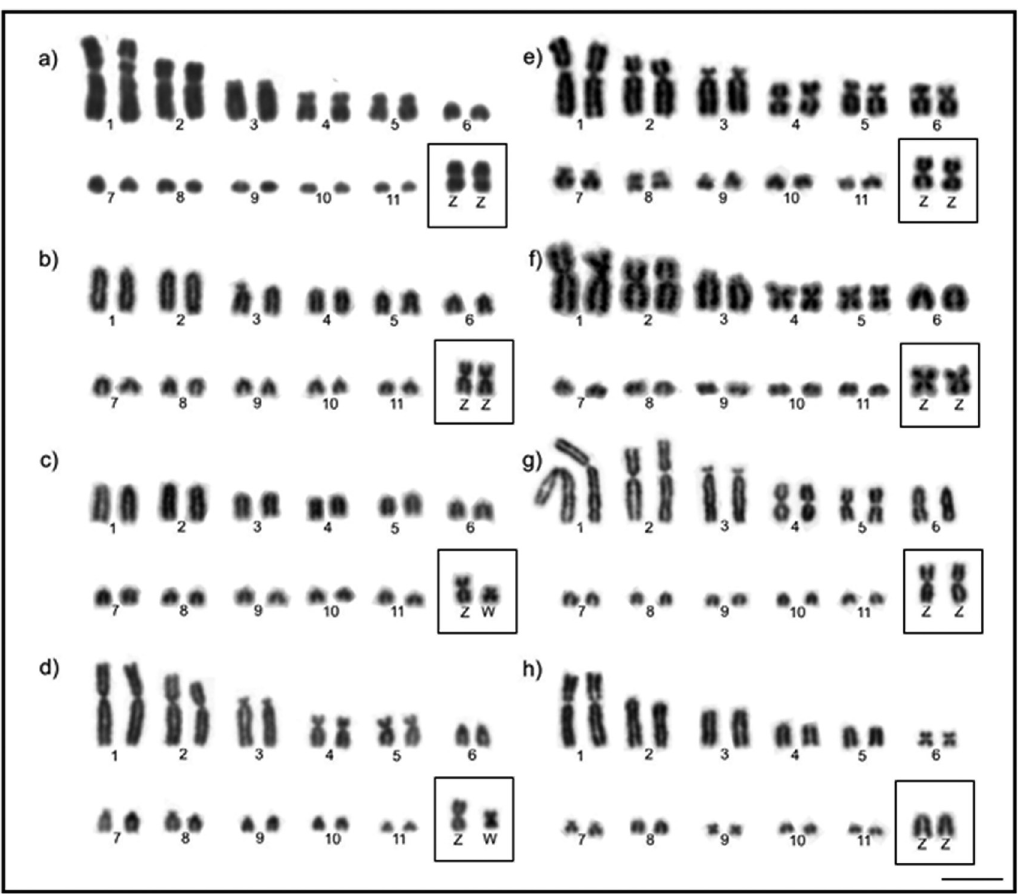
Figure 2 - Partial karyotype showing the largest autosomal pairs and ZW sex chromosomes of eight Columbidae analyzed by conventional Giemsa-staining: (a) Zenaida auriculata , male; (b) Geotrygon montana , male; (c) Geotrygon violacea , female; (d) , Columba livia , female; (e) Patagioenas cayennensis , male; (f) Columbina talpacoti , female; (g) Columbina passerina , male; (h) Columbina picui , male. Sex chromosomes are boxed. Bar = 5 (cid:2)